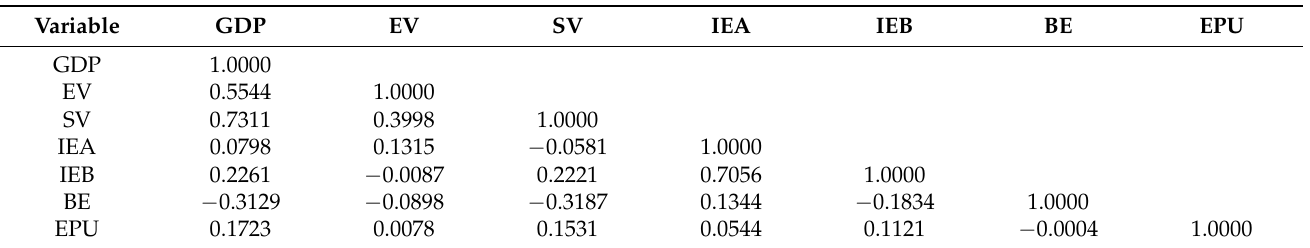
Table 2. Correlation coefficient